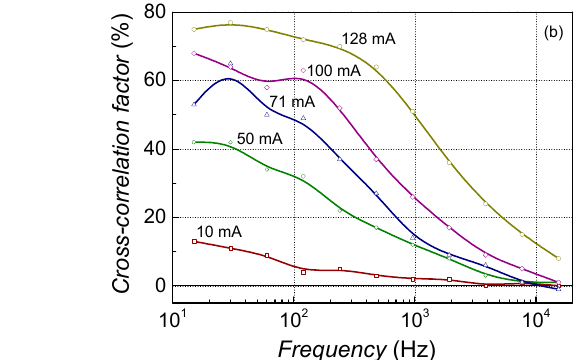
Figure 4. Typical electrical noise spectra of the investigated laser diodes at room temperature at small currents below the threshold ( a ) and at larger current region around and above the threshold ( b ) (sample No. 6: AlGaAs-based LD with single parabolic QW).